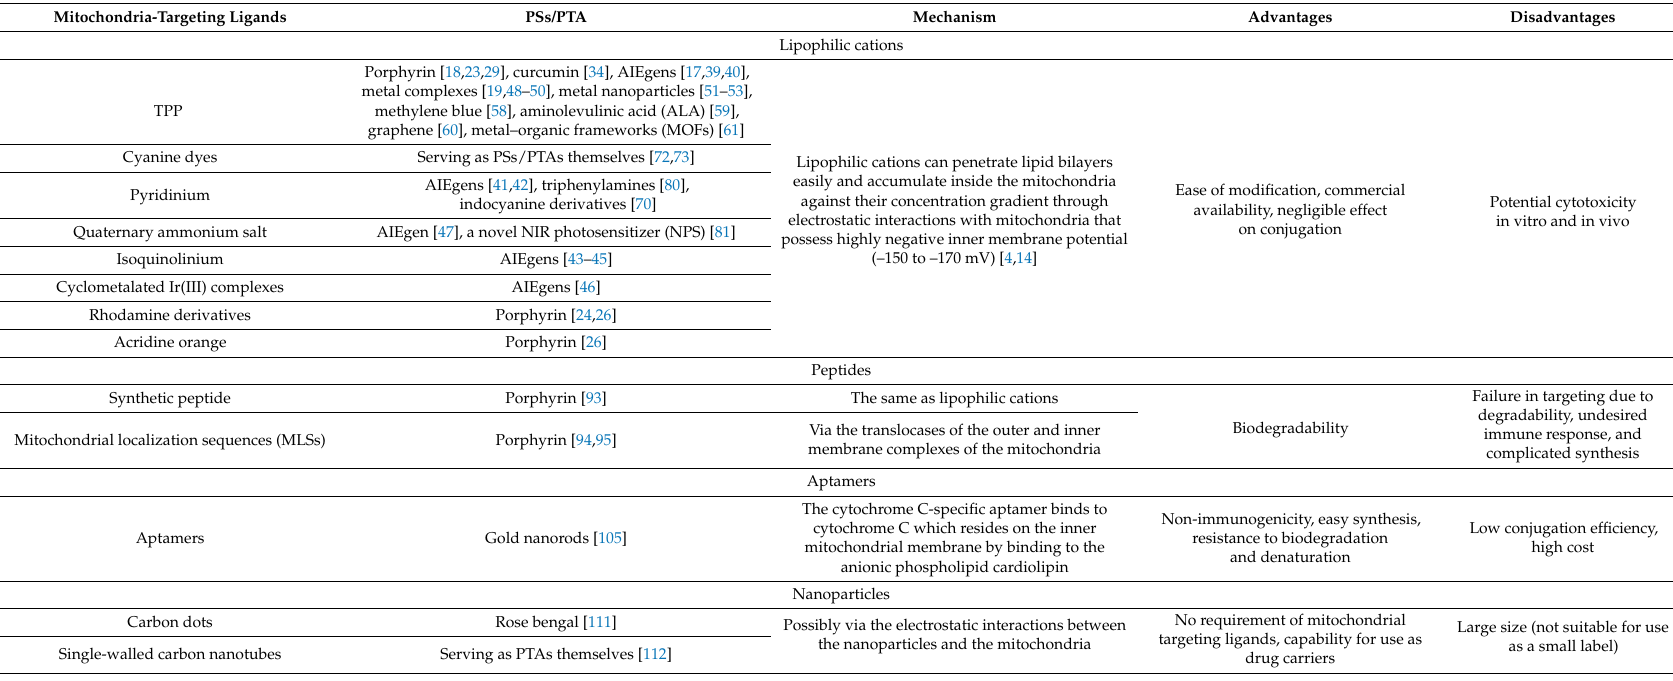
Table 1. Strategies for mitochondria-targeted